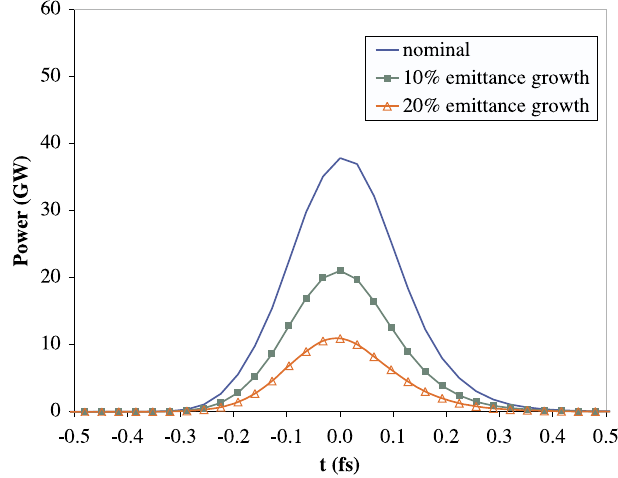
FIG. 12. (Color) Average temporal profile of beam power from the main peak in current, for different normalized